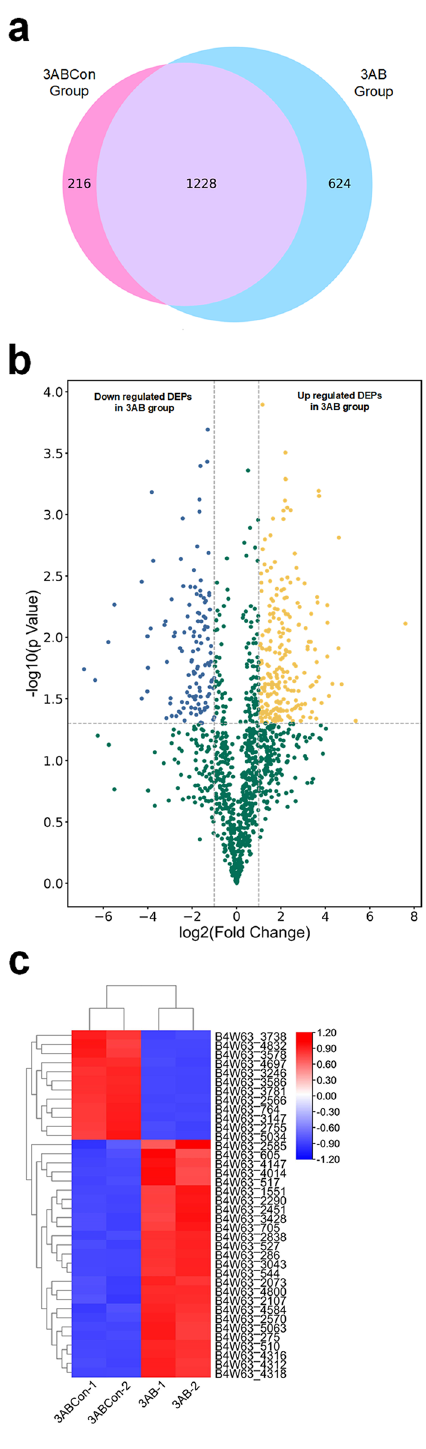
Figure 1. Analysis of the difference between protein quantity and protein produced by cultured QT12 in 3AB group and 3ABCon group. ( a ) Venn diagram analysis of the proteins in 3AB group and 3ABCon group. ( b ) Volcano plot analysis of the identified proteins showing the DEPs. Blue plots, downregulated DEPs in 3AB group; Yellow plots, upregulated DEPs in 3AB group; Green plots, proteins without differential expression. ( c ) Results of heat map analysis of differential protein of strain QT12 under 3AB group and 3ABCon